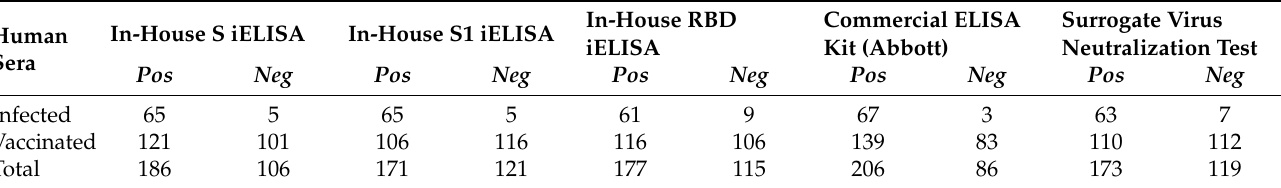
Table 2. Number of positive and negative sera from SARS-CoV-2-infected or -vaccinated